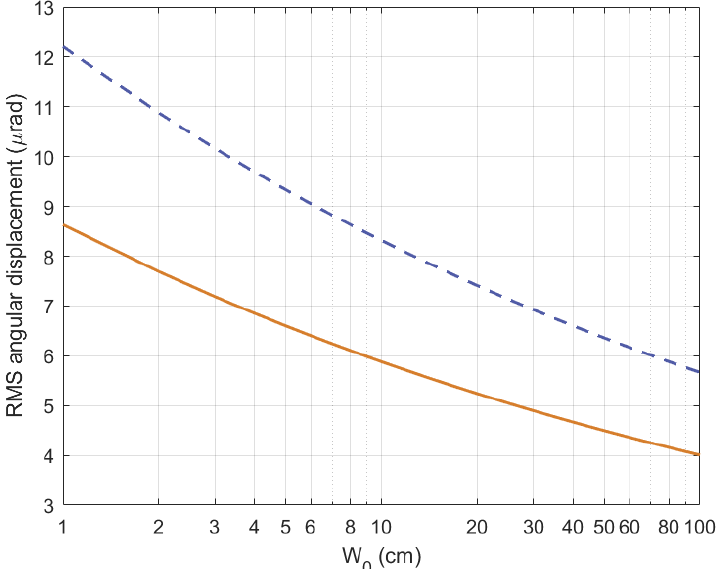
Figure 6. Root Mean Square (RMS) angular beam wander ( σ 2 ) as a function of the beam radius ( W 0 ) BW for a transmitter in the ground and a satellite in the space assuming λ = 1.55 µ m and a refractive index structure following the H-V 5/7 model (wind speed: v = 21 m/s). Zenith angle: ζ = 0 deg. (solid orange line) and ζ = 60 deg. (dashed purple